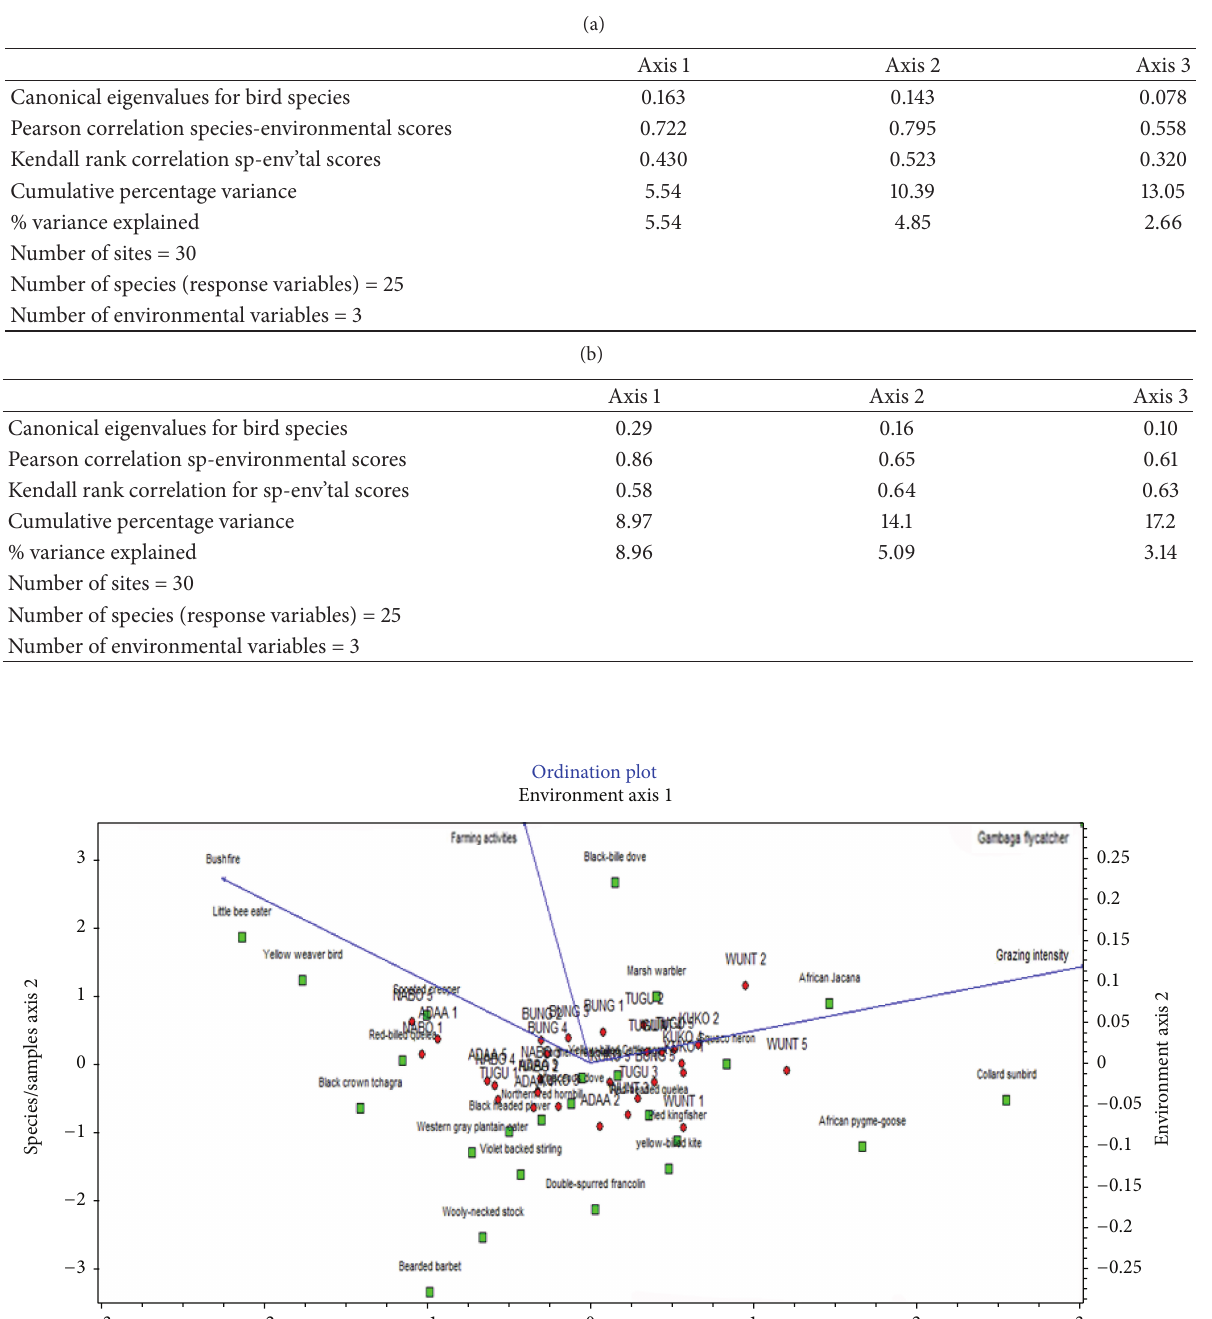
Table 3: (a) Summary of CCA axis lengths for birds, showing the levels of correlation between axes and environmental gradients, percentage variance of species, and species-environment relationships ( wet season ). (b) Summary of CCA axis lengths for birds, showing the levels of correlation between axes and environmental gradients, percentage variance of species, and species-environment relationships ( dry season ) .